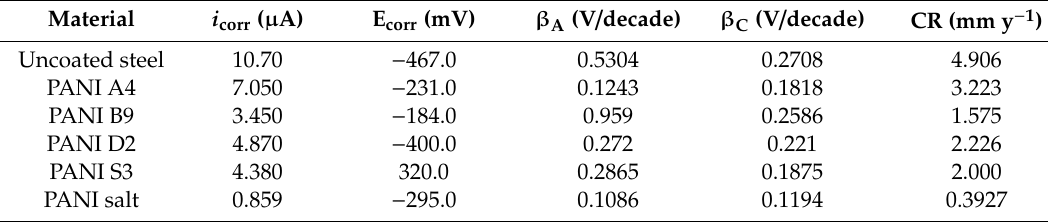
Table 8. Values of i corr ( µ A), E corr (mV), β A (V / decade), β C (V / decade) and CR (mm y − 1 ) for di ff erent samples of PANI salt.